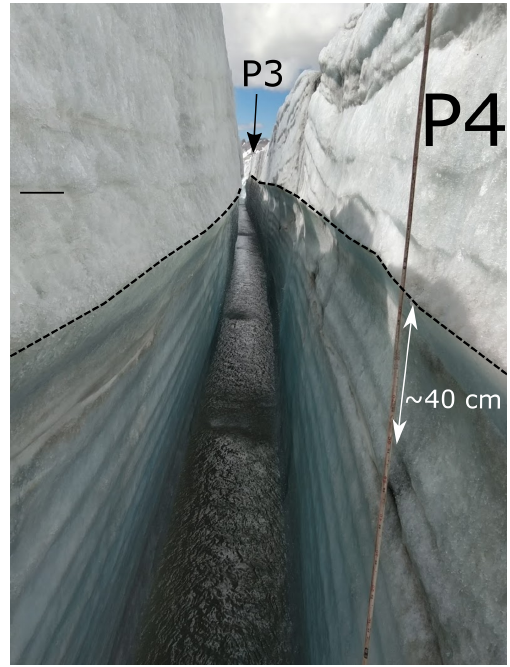
Figure 4. Photo from within the supraglacial channel from P4 to- wards P3. The dashed line represents the highest water stage in the channel (10 July 2019) prior to the supraglacial lake drainage start and prior to the onset of the channel bottom incision. Daily water level cuts are clearly visible on both sides. The picture was taken on 30 July 2019.